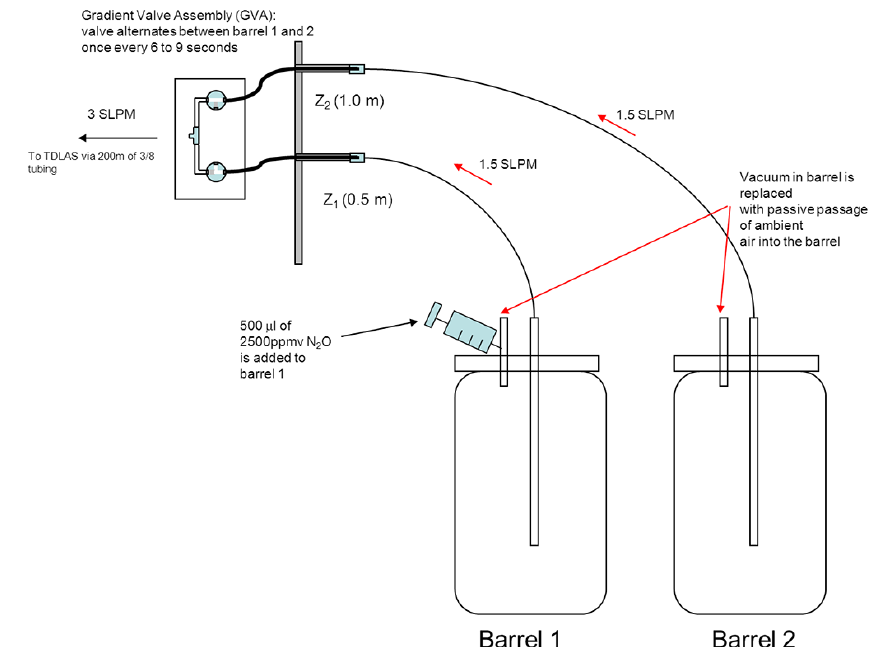
Fig. 3. Method to determine minimum resolution of N 2 O gradient using 60L ballast